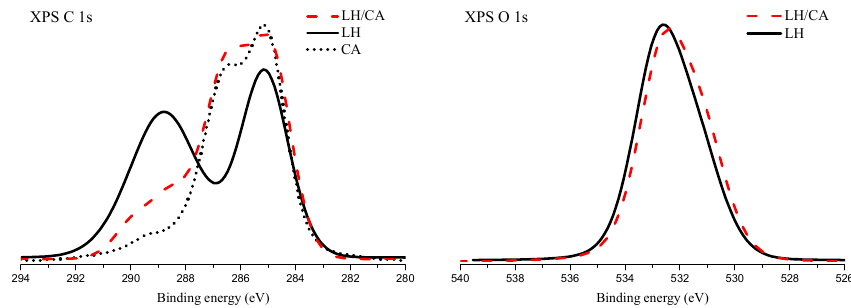
Figure 2. X-ray photoelectron spectra of C 1s transition ( left panel) and O 1s transition ( right panel) acquired for aluminum-magnesium hydroxycarbonate (LH) before (black line) and after (red line) modification with carminic acid (20%). XPS C 1s spectrum of pure carminic acid is depicted by dotted plot.